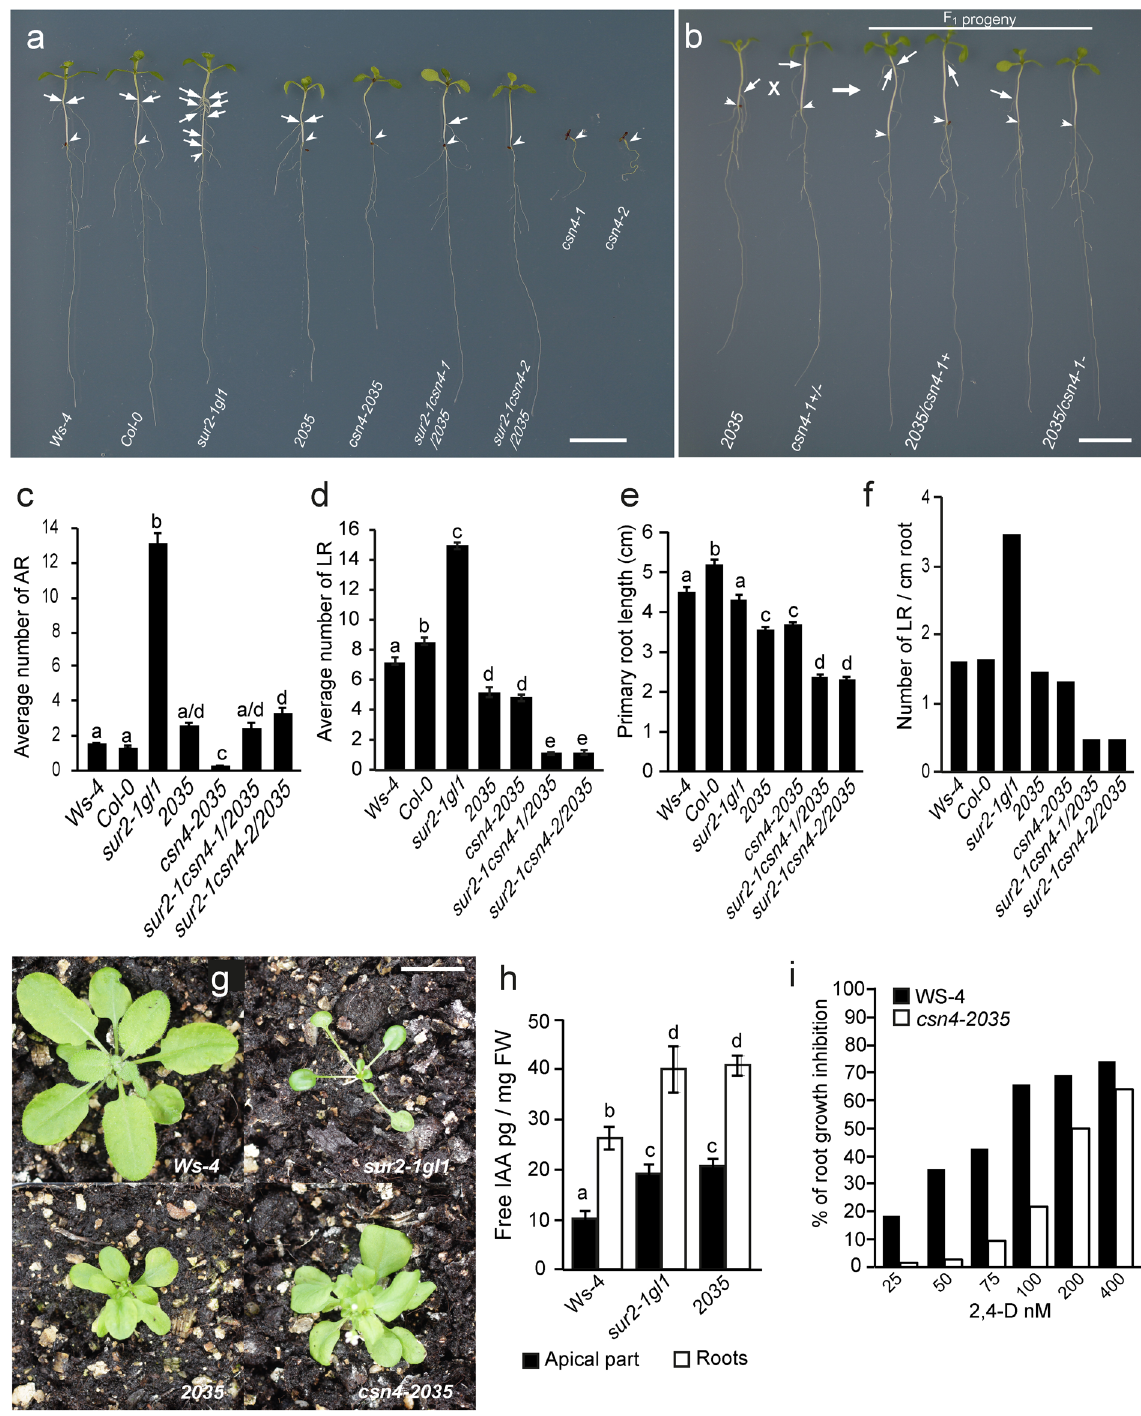
Figure 2. Phenotype and characterization of the csn4 alleles. (a) The phenotype of in vitro grown 2035 suppressor mutant, together with Ws-4 , Col-0 , sur2-1gl1 , csn4-2035 , the two trans-heterozygotes double mutants, sur2-1csn4-1/csn4-2035 and sur2-1csn4-2/csn4-2035 , respectively, is shown, as compared to the non- viable csn4-1 and csn4-2 alleles. Seedlings were first etiolated in the dark, until their hypocotyls were 6 mm long, and then transferred to light for seven days to induce AR formation on the etiolated hypocotyls. Arrowheads indicate the root-hypocotyl junction; arrows indicate ARs. Bar, 5 mm. ( b) Allelism test. A cross between the homozygous 2035 and the heterozygote csn4-1 gives a 1:1 wild-type to mutant phenotype segregation ratio in the F 1 generation. Arrowheads indicate the root-hypocotyl junction; arrows indicate ARs. Bar, 5 mm. (c) Numbers of AR were counted on the hypocotyls treated as in ( a ), and averaged. (d) Numbers of emergent lateral roots were counted on seedlings grown in vitro directly in light conditions for 10 d and averaged. (e) Primary root length was measured on the same seedling as in (d) and averaged. (f) Lateral root density was